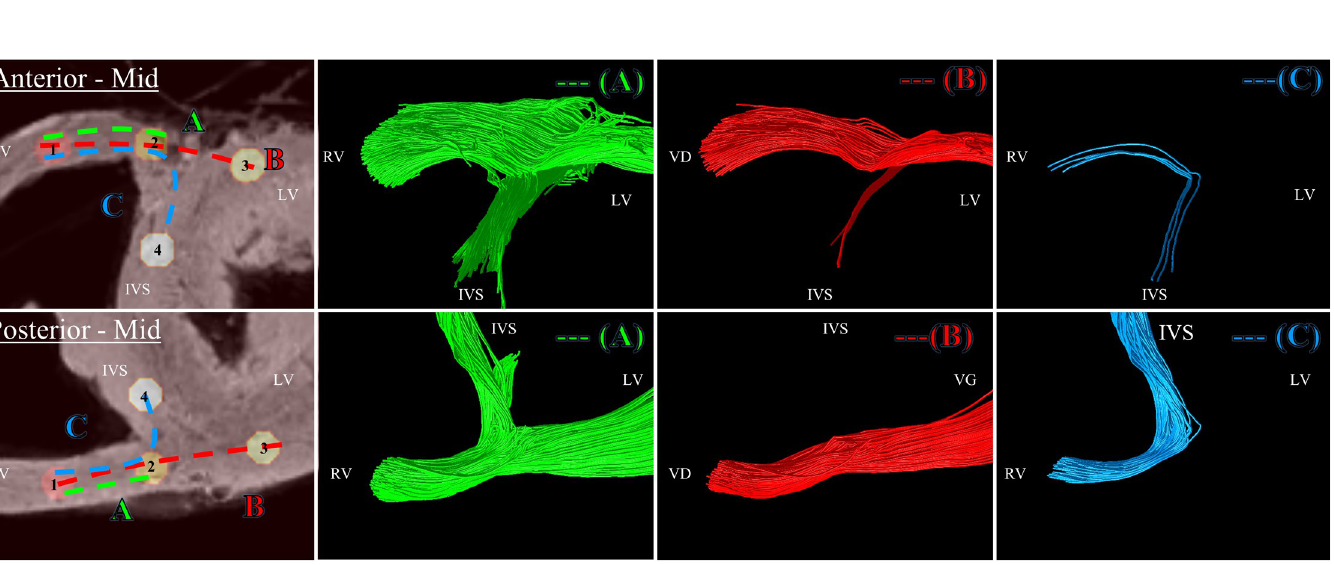
PLOS ONE | https://doi.org/10.1371/journal.pone.0271279 July 18,